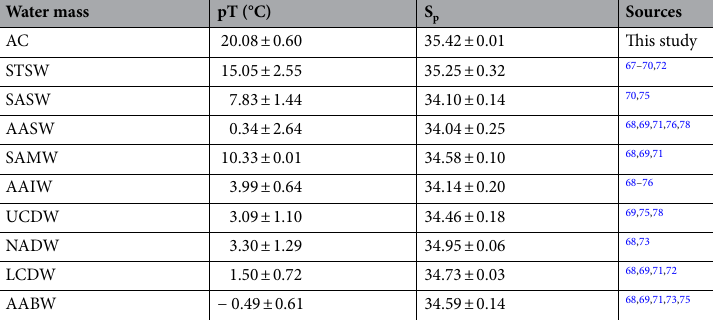
Table 3. In situ properties of different water masses. AC, Agulhas water; STSW, subtropical surface water; SASW, Subantarctic surface water; AASW, Antarctic surface water; SAMW, Subantarctic mode water; AAIW, Antarctic intermediate water; UCDW, upper circumpolar deep water; NADW, North Atlantic deep water; LCDW, lower circumpolar deep water; AABW, Antarctic bottom